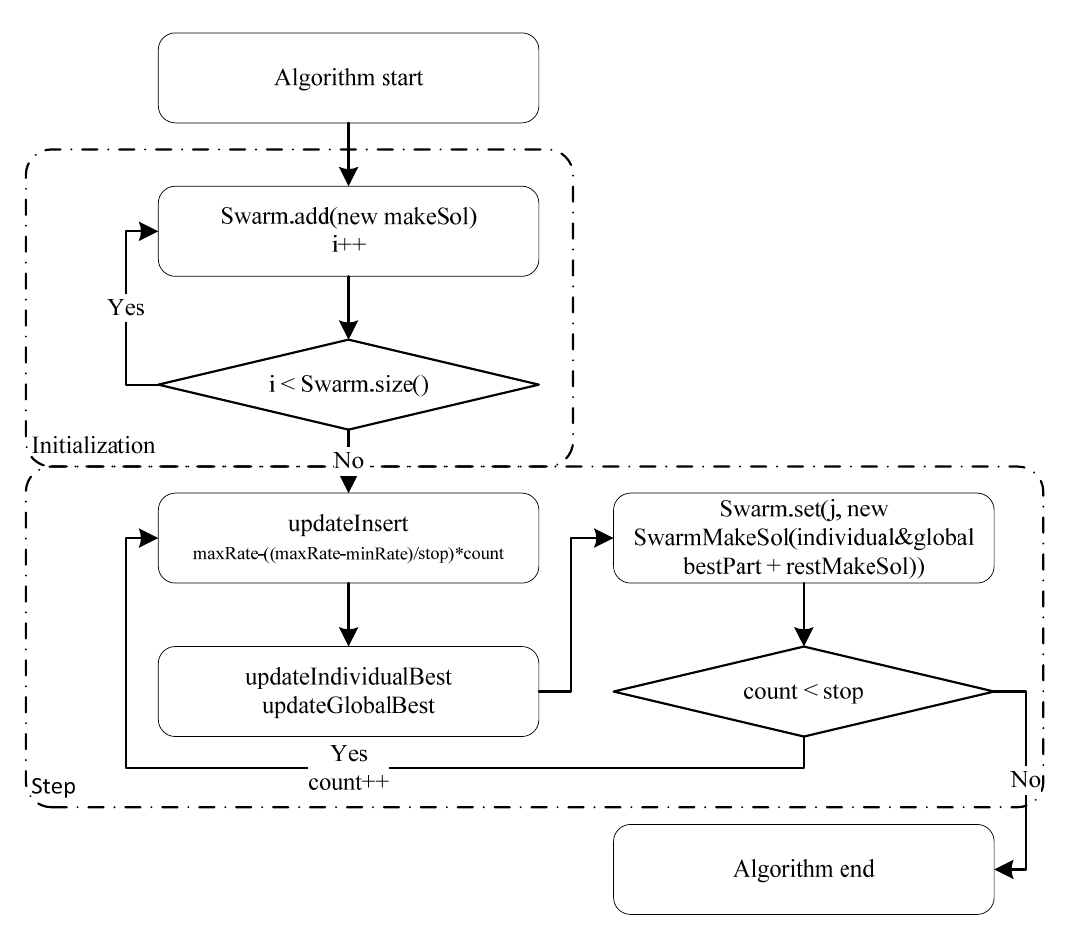
Figure 7. The flowchart of PSO.